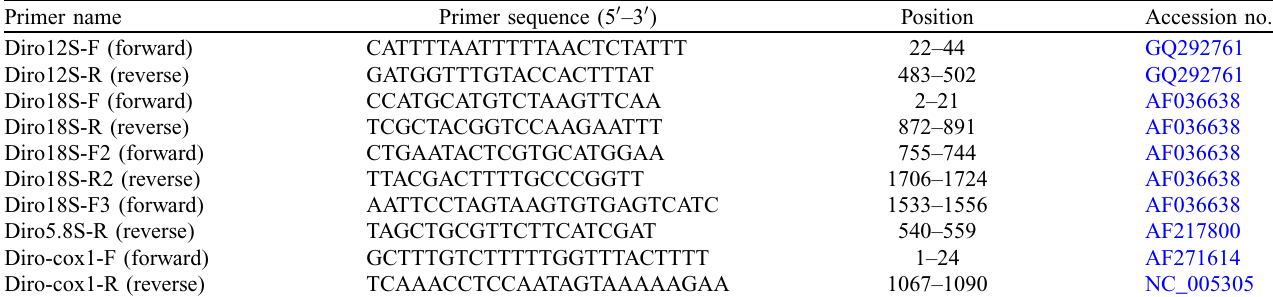
Table 1. Oligonucleotide primers used for PCR assays in the present study. Primer